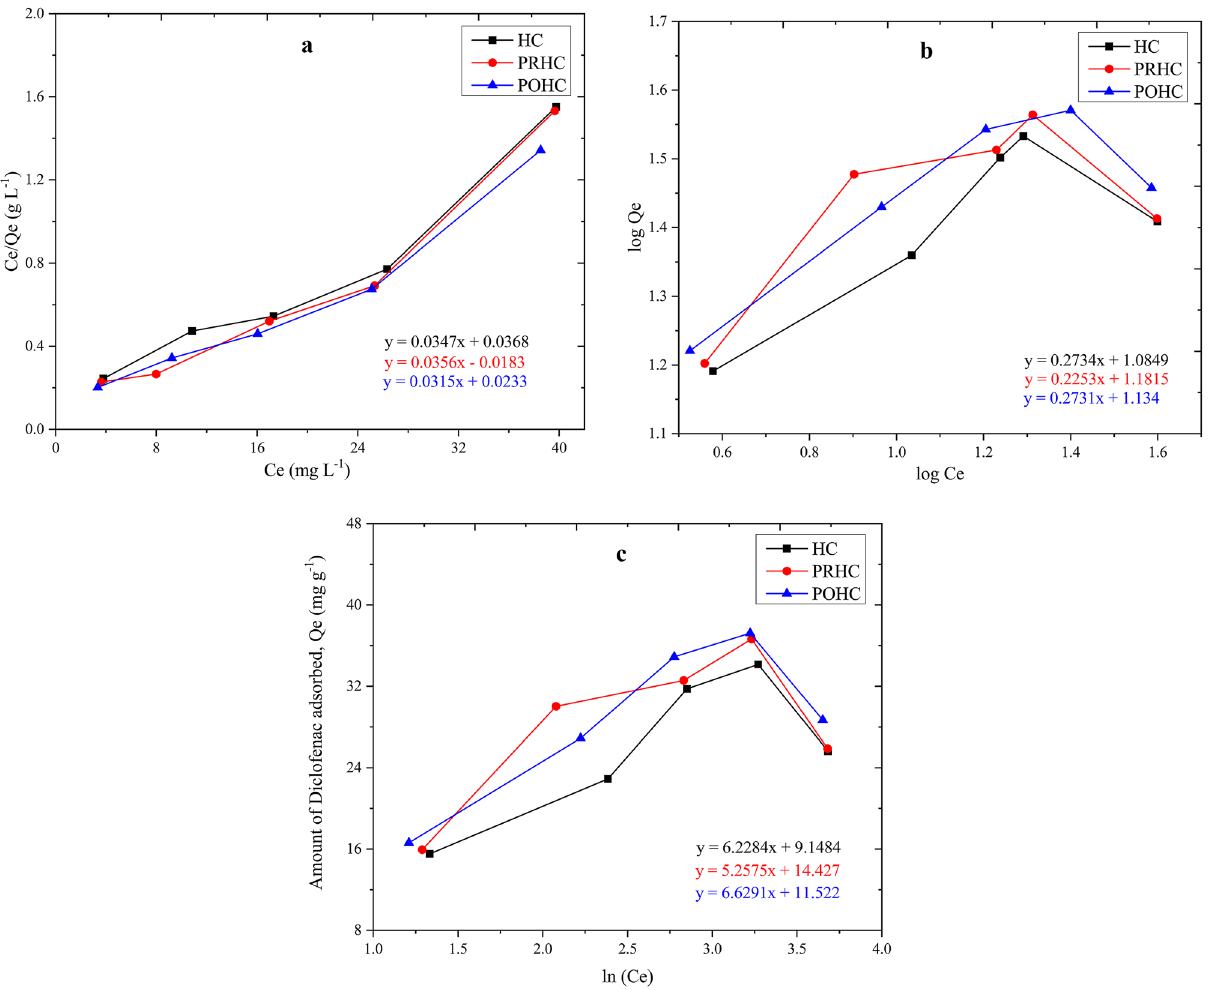
Figure 8. Isotherms of Diclofenac removal ( a ) Langmuir, ( b ) Freundlich and ( c ) Temkin.